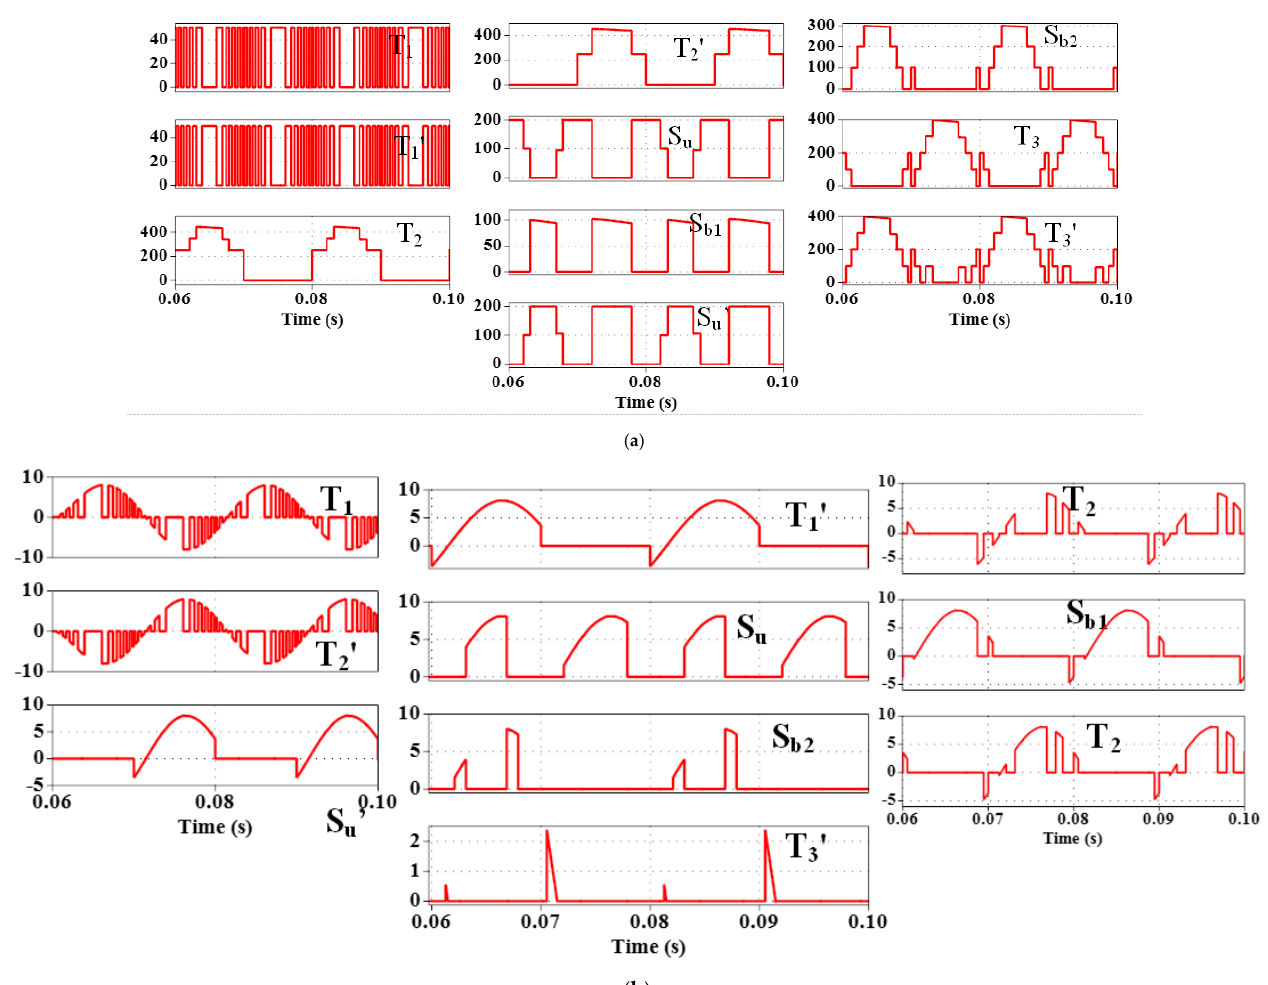
Figure 7. Switch stresses during simulation ( a ) Voltage Stress ( b ) Current Stress.